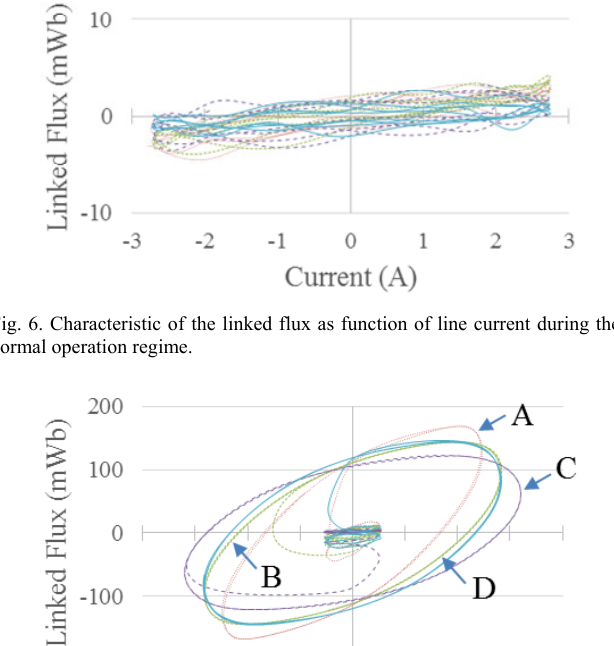
(d) Fig. 5. Different configurations of the SFCL. The primary and secondary coils are painted with white and black background, respectively. Dewars are used to keep superconducting coils below their critical temperature. (a) Configuration A. (b) Configuration B. (c) Configuration C. (d) Configuration D. Fig. 7. Characteristic of the linked flux as function of line current during the transition from fault operation regime to normal operation